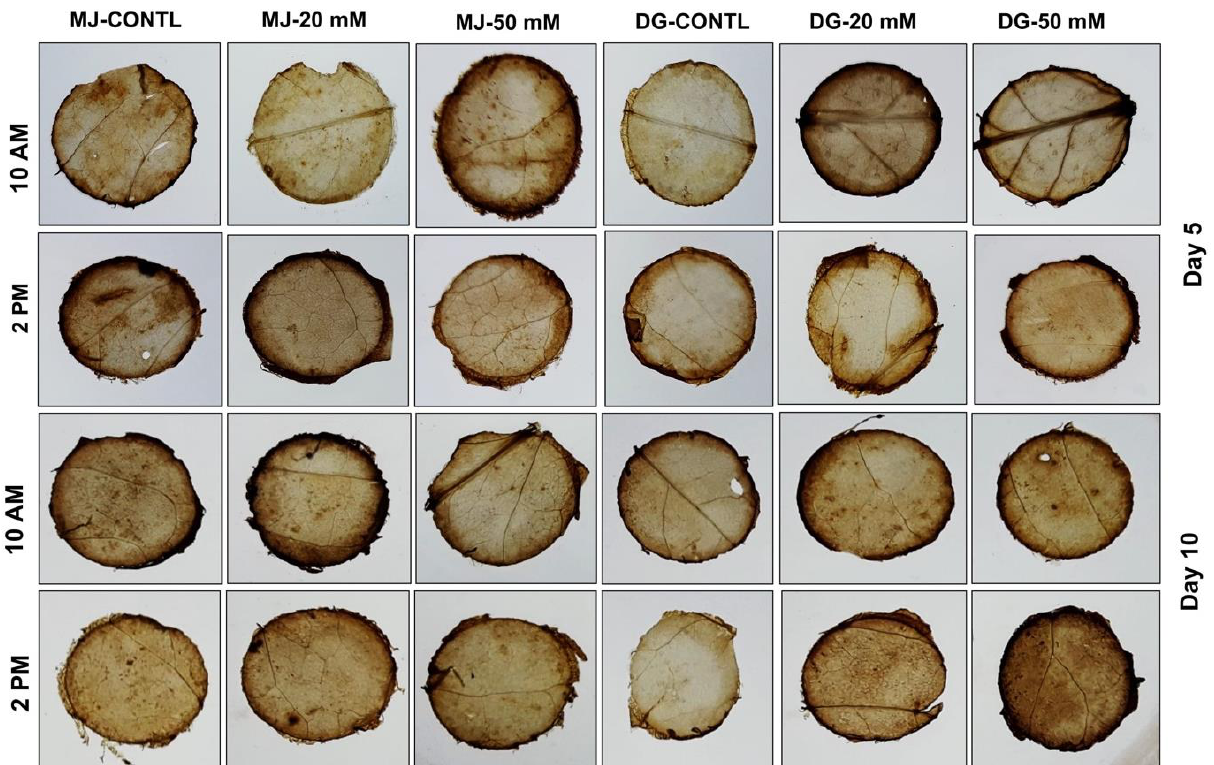
Figure 4. H 2 O 2 localizations in spinach genotypes Delhi green (DG) and Malav Jyoti (MJ). Images are presented for the controls (MJ control; DG control), 20 mM of NaCl treatments (MJ-20 mM; DG-20 mM), and 50 mM of NaCl treatments (MJ-50 mM; DG-50 mM). Sampling was performed (on the basis of the circadian cycle) at 4 h intervals which were exactly at the times of 10 am and 2 pm on both day 5 and day 10 of the salinity stress treatments.